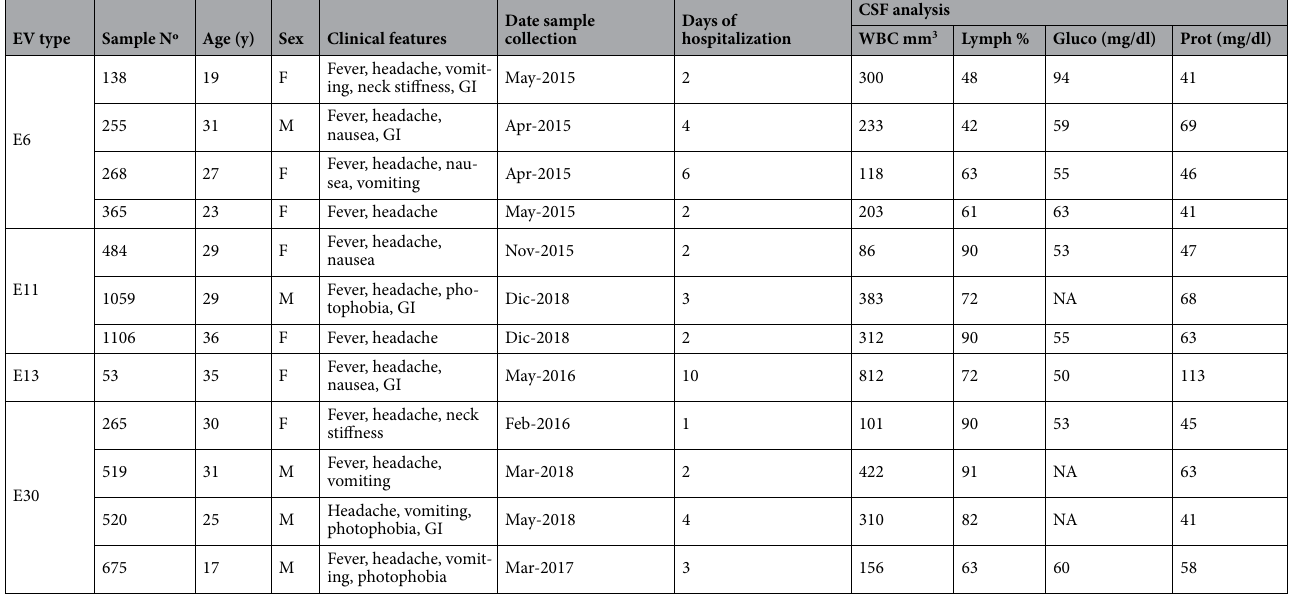
Table 1. Clinical features and laboratory findings for the cases of enteroviral meningitis, Córdoba, Spain, 2015–2018. EV enterovirus, CSF cerebrospinal fluid, GI gastrointestinal symptoms, Gluco glucose, NA not available, Prot proteins, WBC White Blood